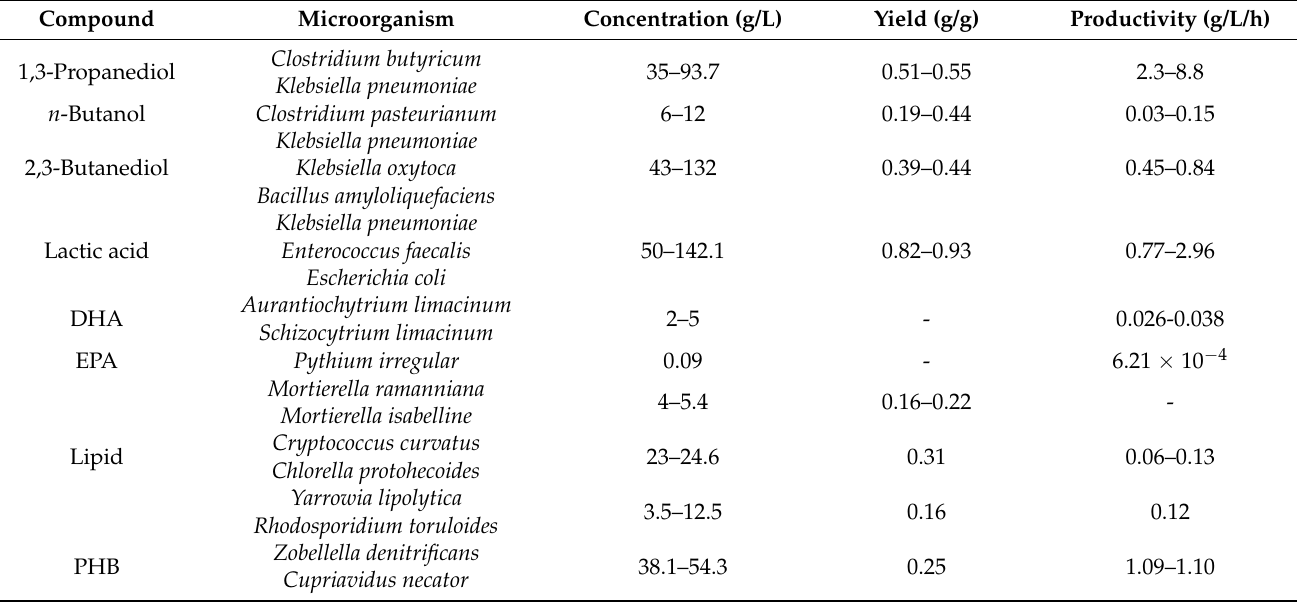
Table 2. Biological conversion of crude glycerol into value-added